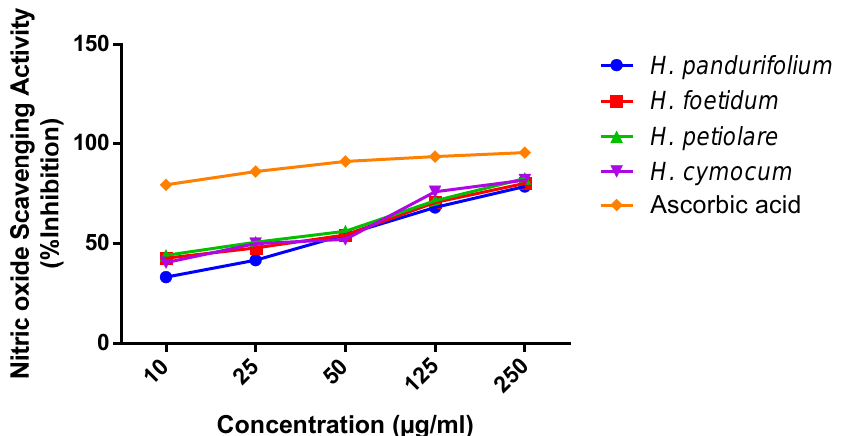
Figure 2. Percentage (%) inhibition of aqueous acetone extract of H. pandurifolium, H. foetidum H. petiolare, and H. cymocum.